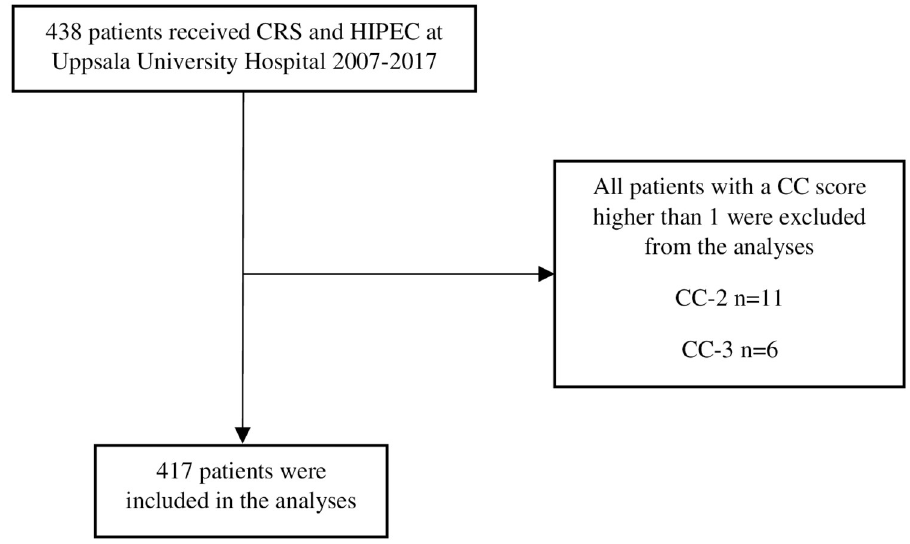
Fig 1. Flowchart of inclusions and exclusions of the study. CRS Cytoreductive surgery HIPEC Hyperthermic intraperitoneal chemotherapy CC score Completeness of cytoreduction score.